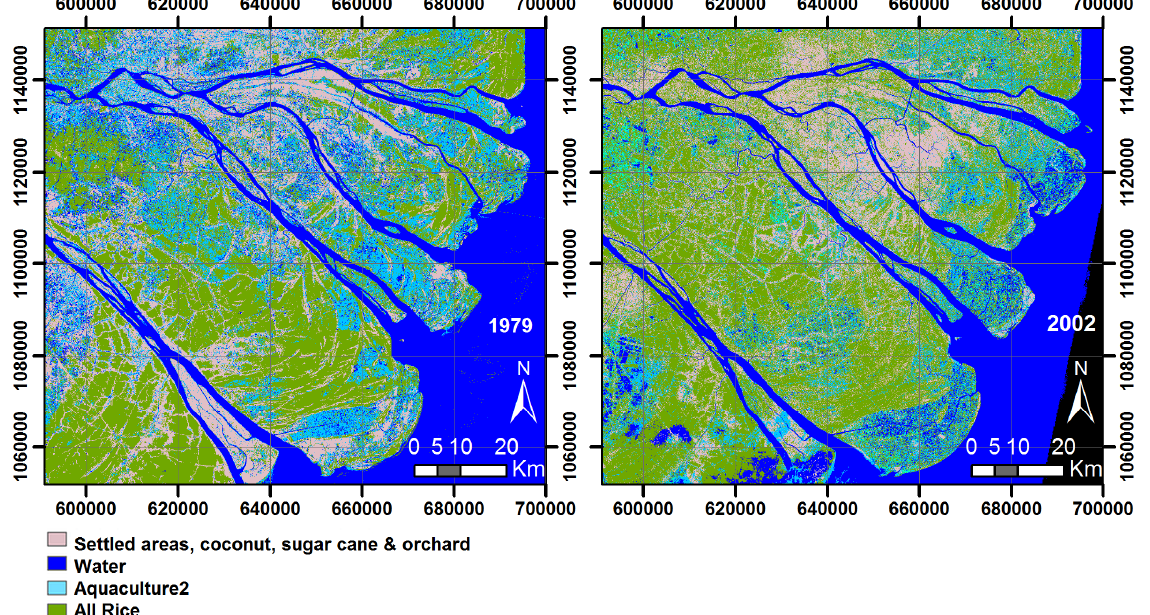
Figure 4. The land-use classifications from the Landsat